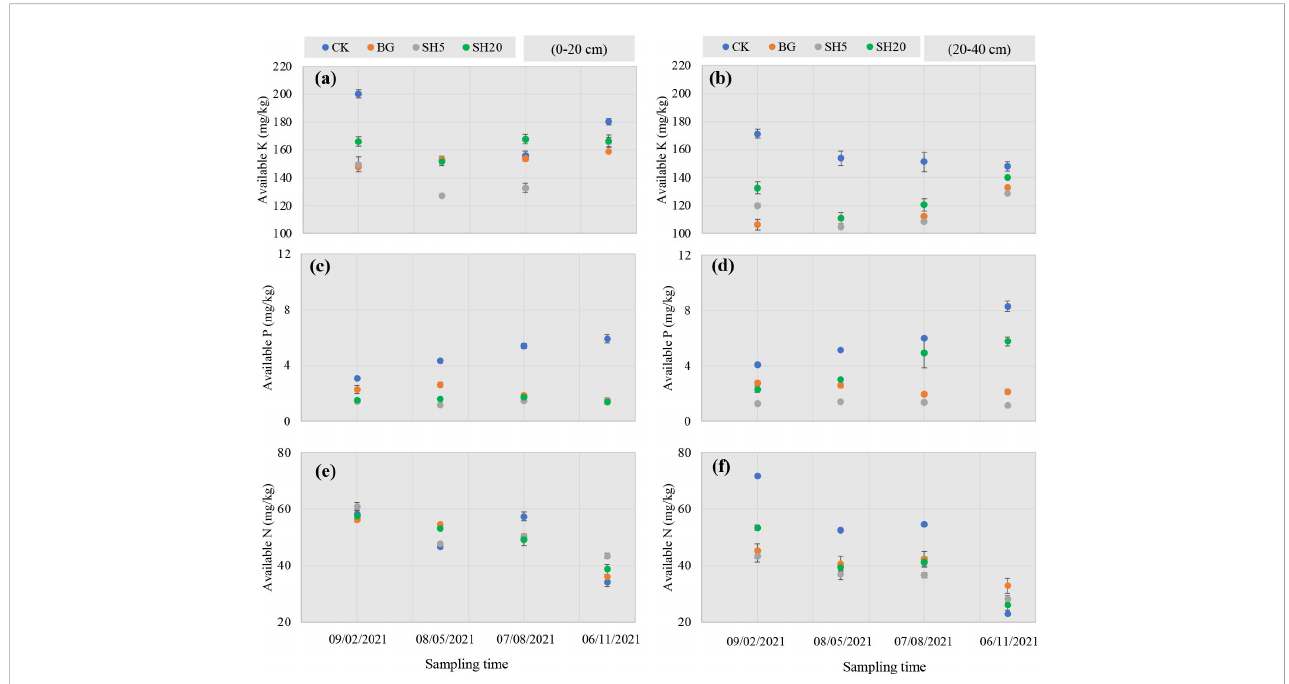
FIGURE 2 Variation of available K (A, B) , P (C, D) , and N (E, F) in soils under different treatments (left, 0 – 20 cm soil layer; right, 20 – 40 cm soil layer) over Miscanthus growth from 09/02/2021 to